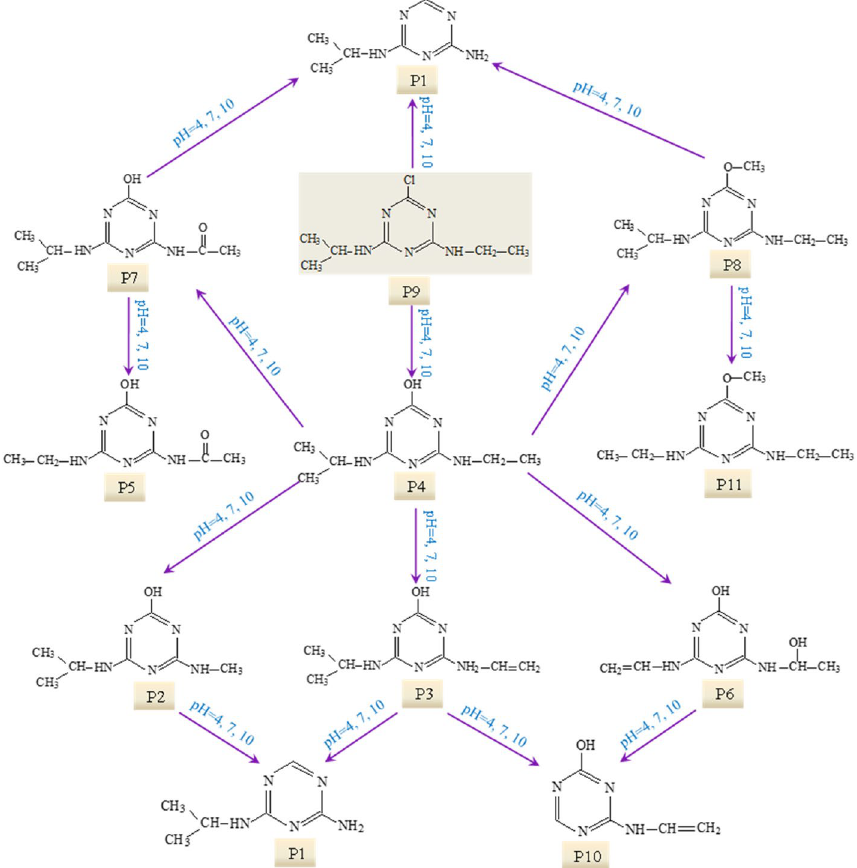
Figure 3. The proposed degradation pathway of ATZ in UV